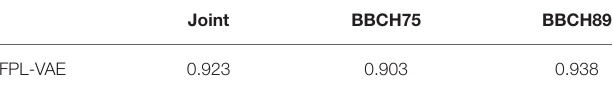
TABLE 4 | Model accuracy for different BBCH stages.